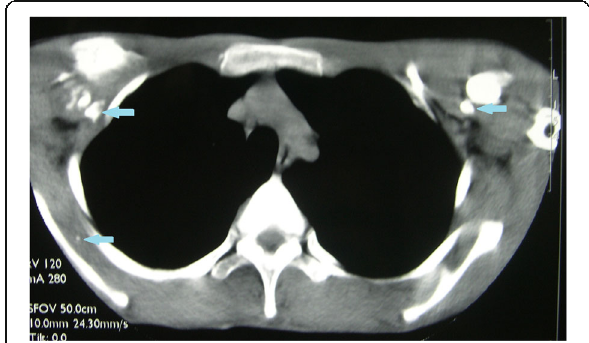
Fig. 3 Lateral radiograph of the cervical spine showing the formation of bony bridge in the nuchal ligament (arrows)